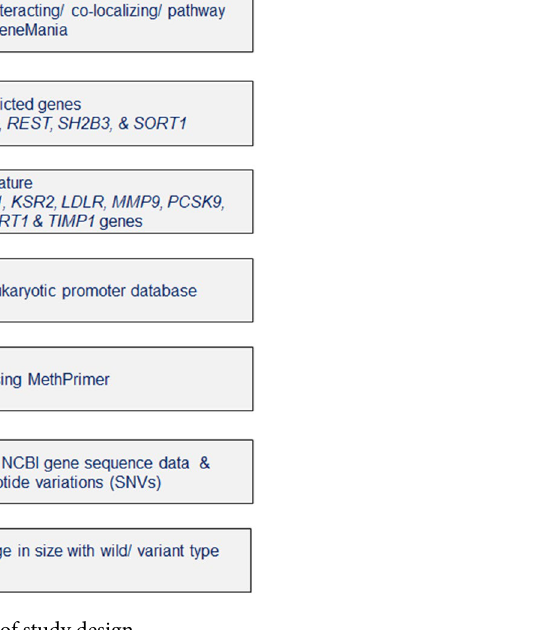
Figure 1. Schematic representation of study